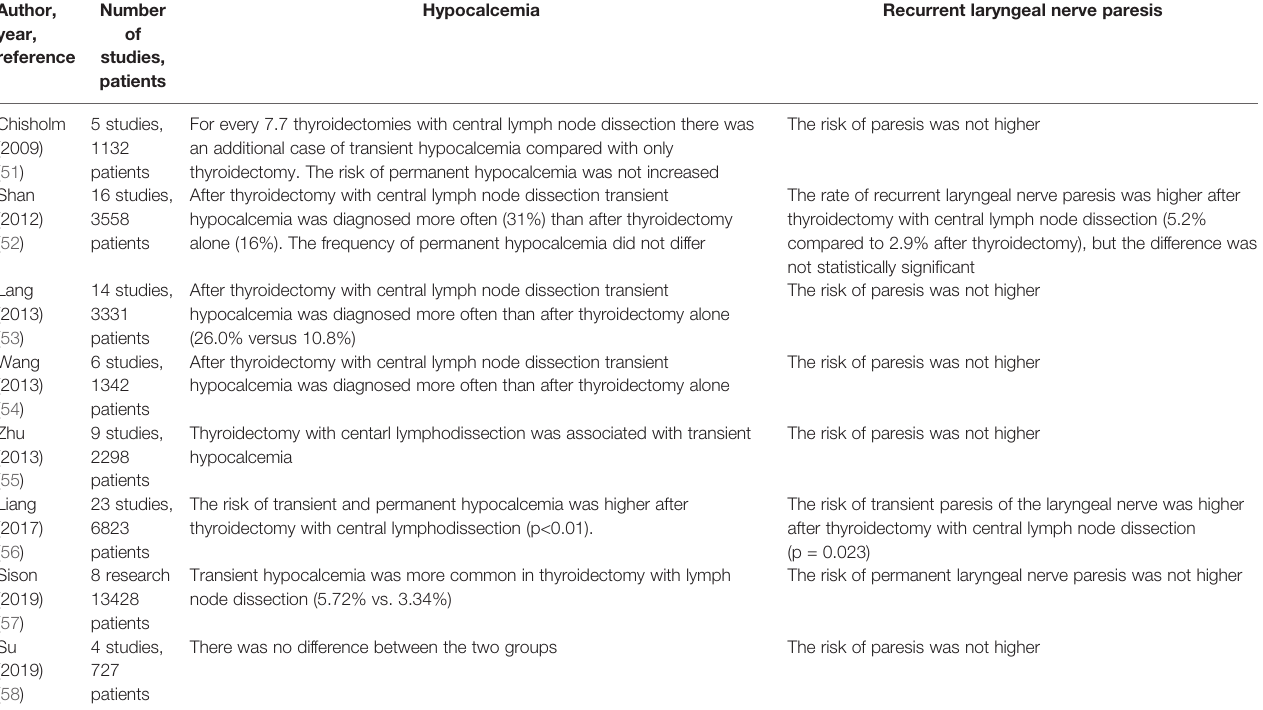
TABLE 2 | Systematic meta-analyses reviews comparing risk hypocalcemia and recurrent laryngeal nerve paresis after thyroidectomy and thyroidectomy with preventive central lymph node